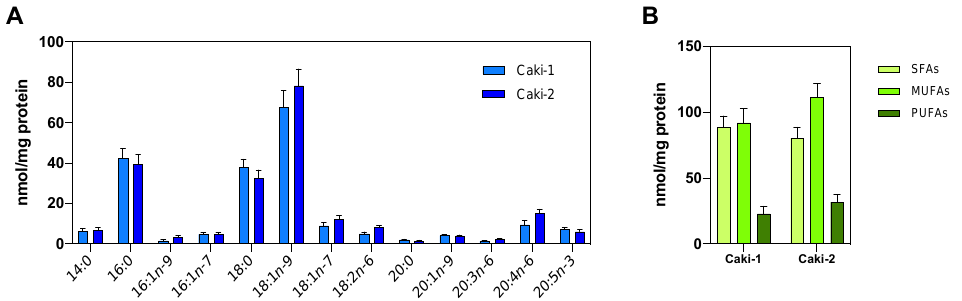
Figure 2. Lipidomic fatty acids profile of the Caki-1 and Caki-2 cell lines. ( A ) Total cellular fatty acid content. ( B ) Distribution of SFAs, MUFAs and PUFAs. Data are expressed as the means ± SEM and are representative of three independent experiments.